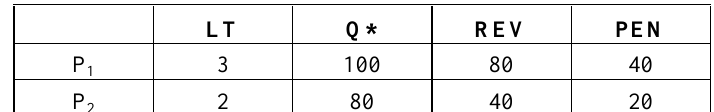
Table 3 : Parameter